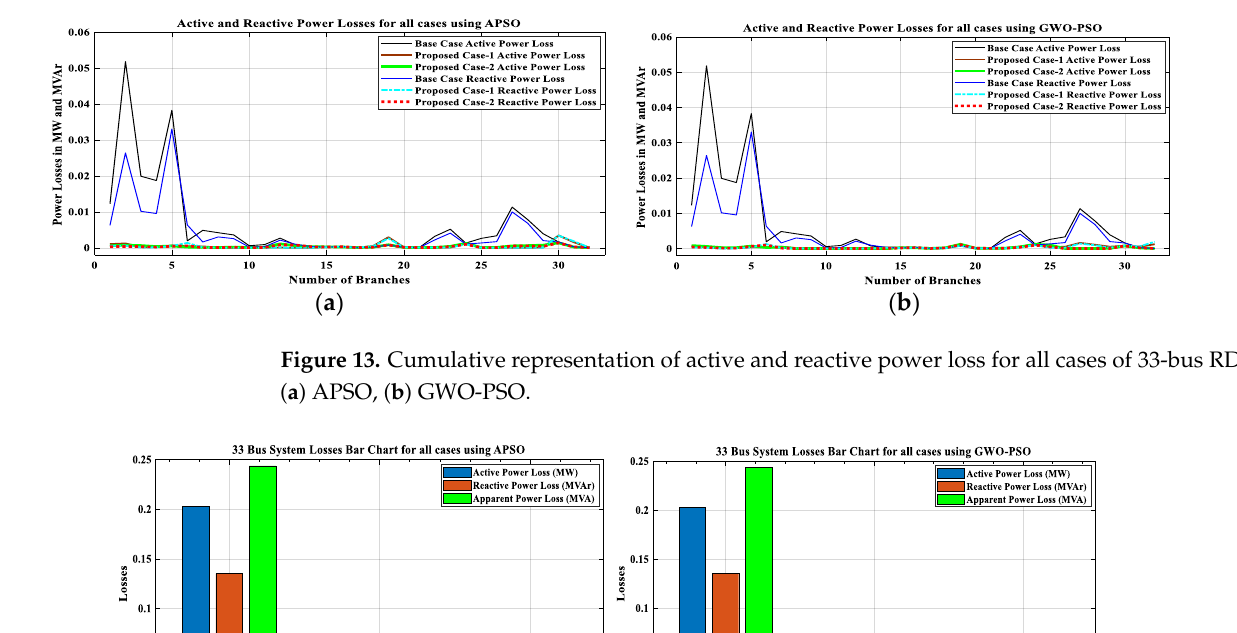
Figure 12. Reactive power loss for all cases of 33-bus RDN; ( a ) APSO, ( b ) GWO-PSO.